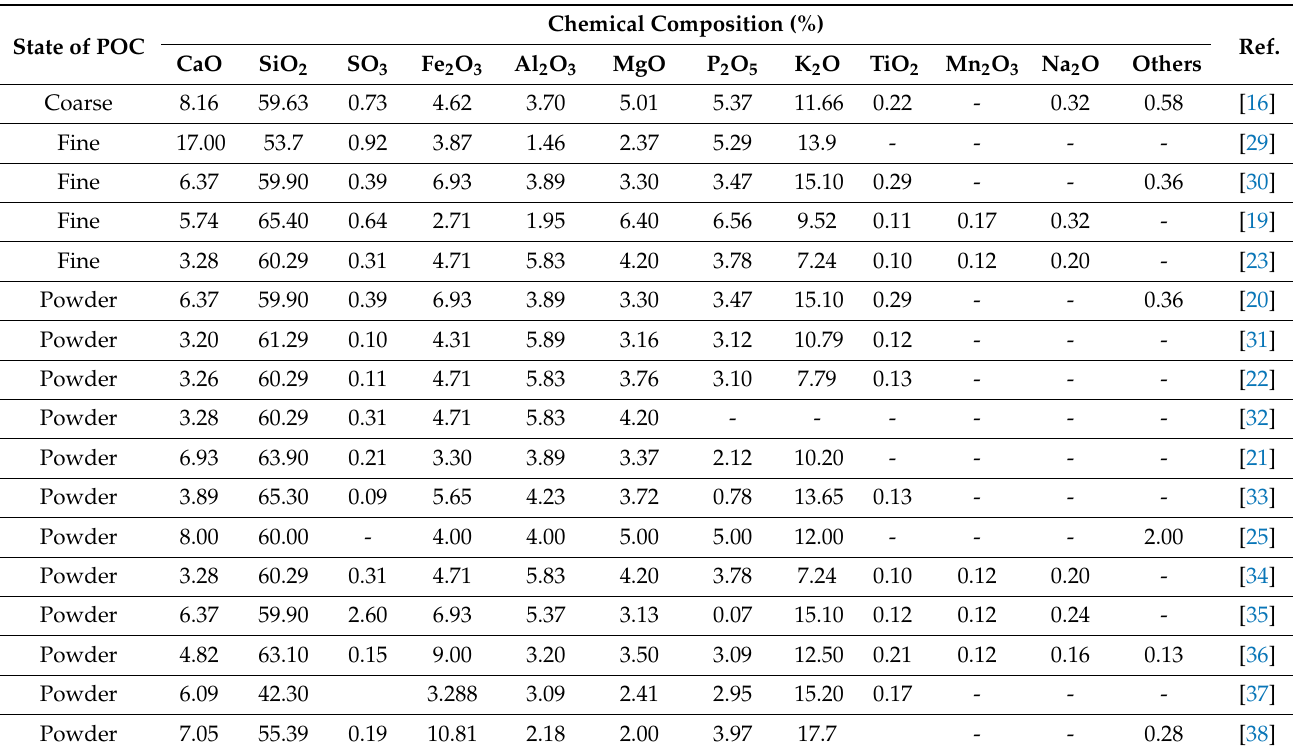
Table 2. Chemical composition of